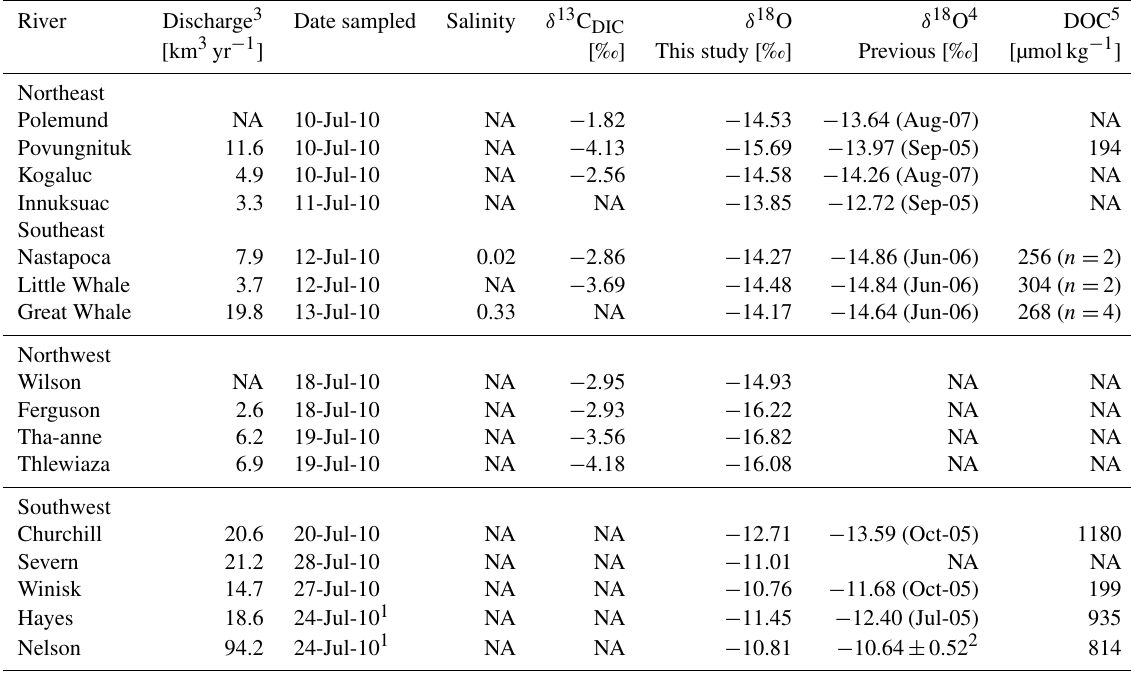
Table 1. Data summary for Hudson Bay rivers. NA: data not available.